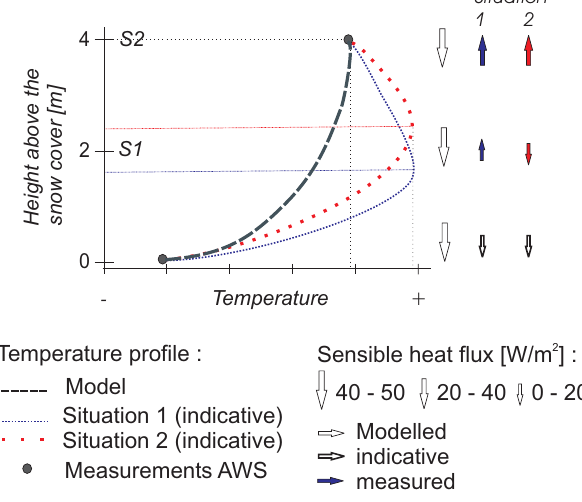
Fig. 11. Schematic sketch of temperature profile and sensible heat fluxes following constant flux layer assumption (model) and mea- sured in the presence of a stable internal boundary layer (SIBL). The sensible heat flux at the snow surface for the non-constant flux layer is only indicative, because no measurement is available at the snow surface. Data belonging to situation 1 and 2 are marked in Fig.